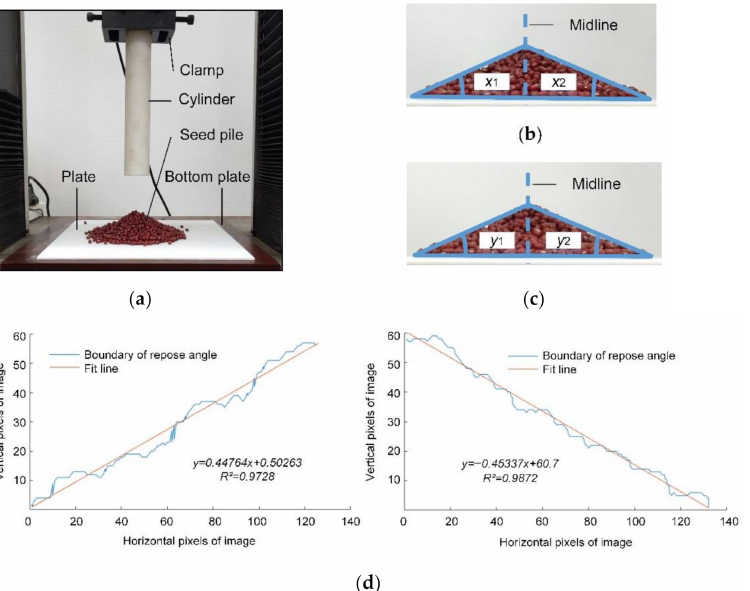
Figure 6. Measurement of AOR. ( a ) AOR measuring device; ( b ) front view; ( c ) side view; ( d ) AOR boundary